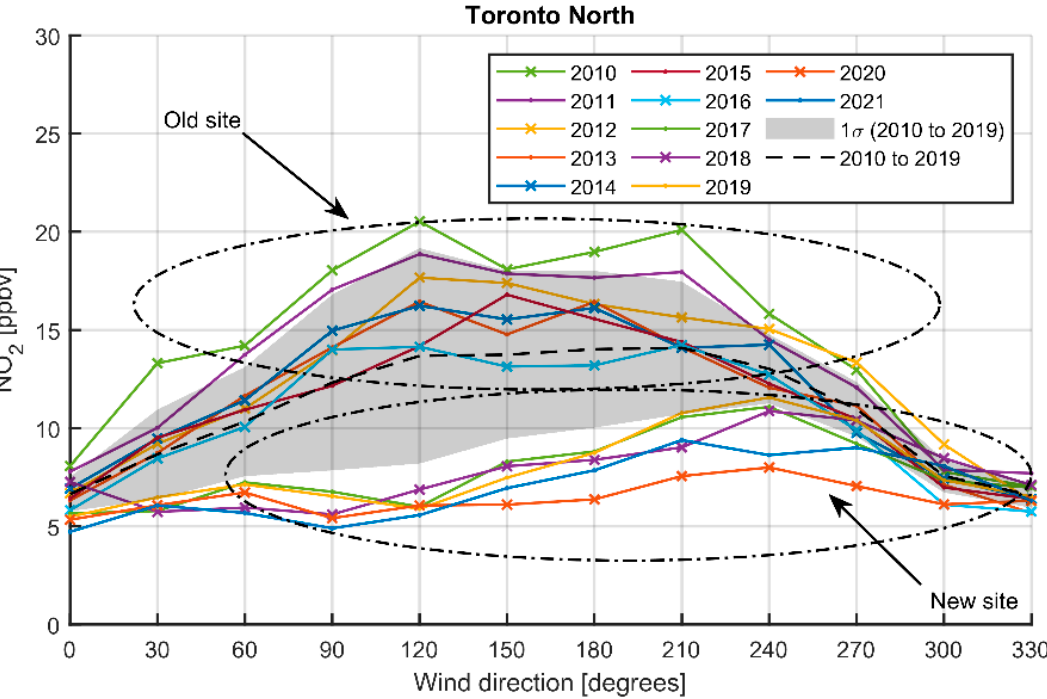
Figure A2. In situ measured NO 2 surface concentration at Toronto North site binned by local standard time (LST) in hours and wind directions (observations from 15 March to 15 September for each year). The black dashed line is the mean of observations from pre-pandemic with shading area representing the standard deviation of the mean.